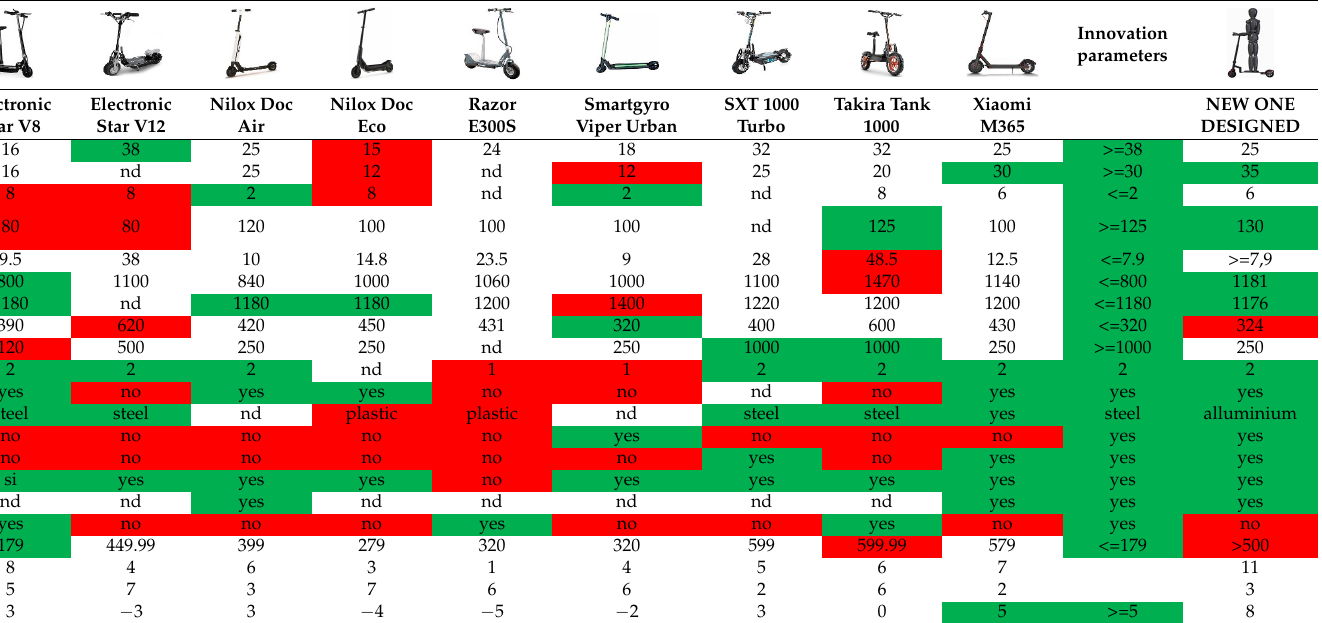
Table 8. New Benchmarking Analysis.